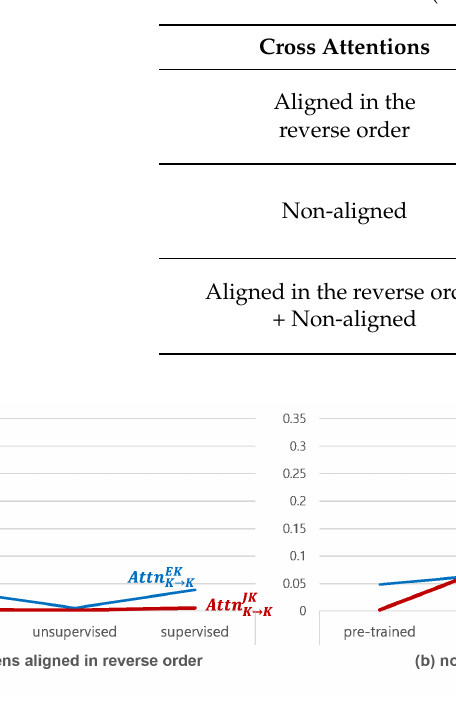
Table 6. The cross-attentions between the same sentences in Japanese–Korean and English–Korean neural machine translation (NMT) models.